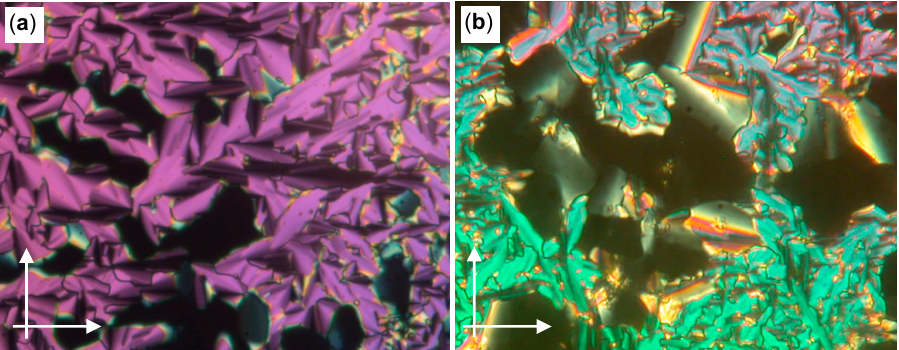
Figure 12. Representative textures of the Col hex phases of compounds with extended polar groups; ( a ) compound C 5 12/12 at T = 111 °C (the texture of C 4 12/12 is shown in Figure S3), and ( b ) D 3 4F6 at T = 120 °C; the dark areas in both textures represent homeotropic areas where the columns are aligned perpendicular to the glass substrates, indicating optical uniaxiality of these columnar phases; the orientation of the polarizers is indicated with arrows.